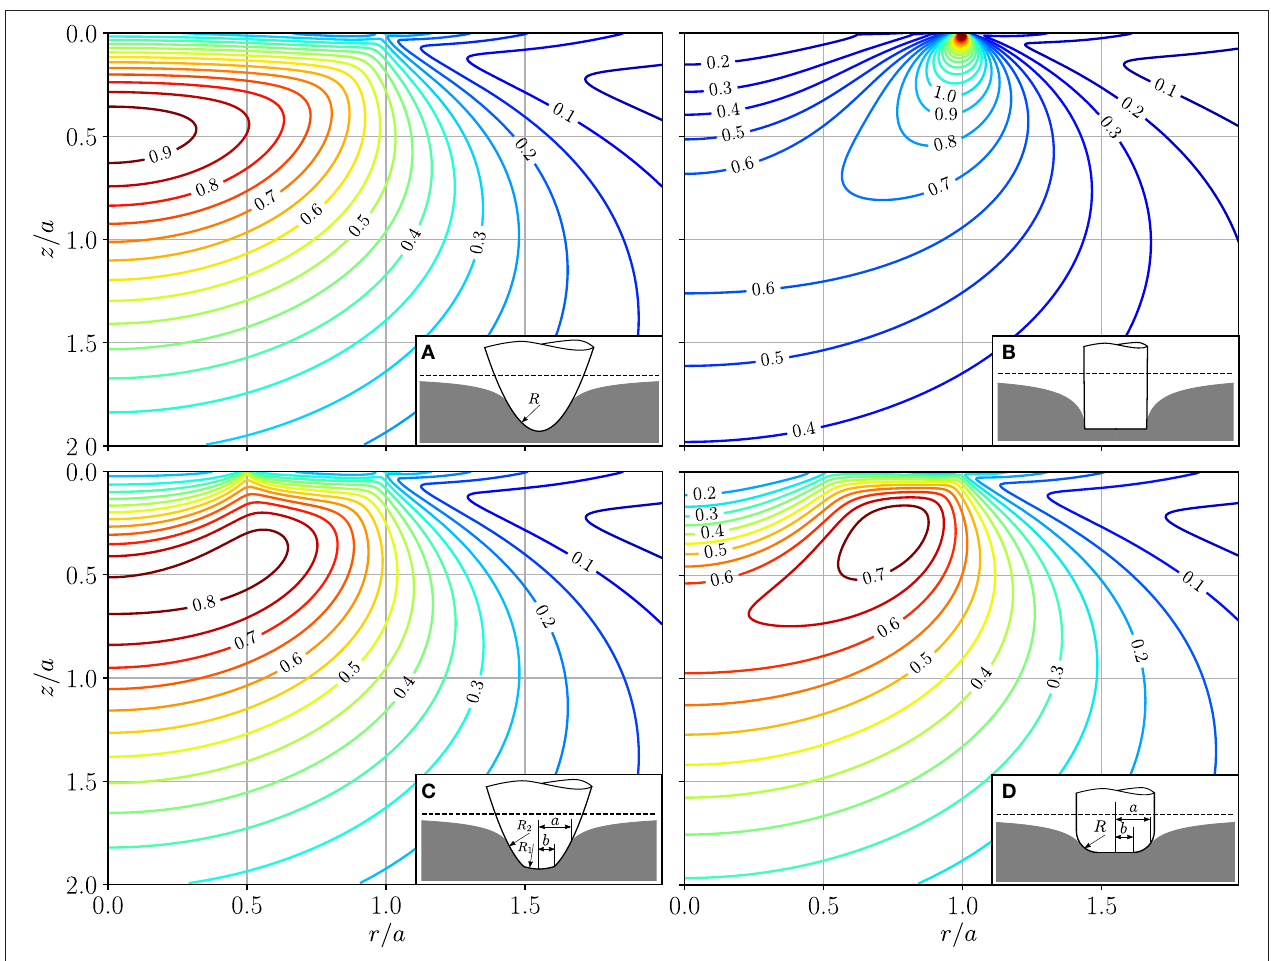
0.3 for different indenter shapes with indentation = 0.5 and R 1 3 R 2 , (D) Cylindrical flat punch with rounded = =